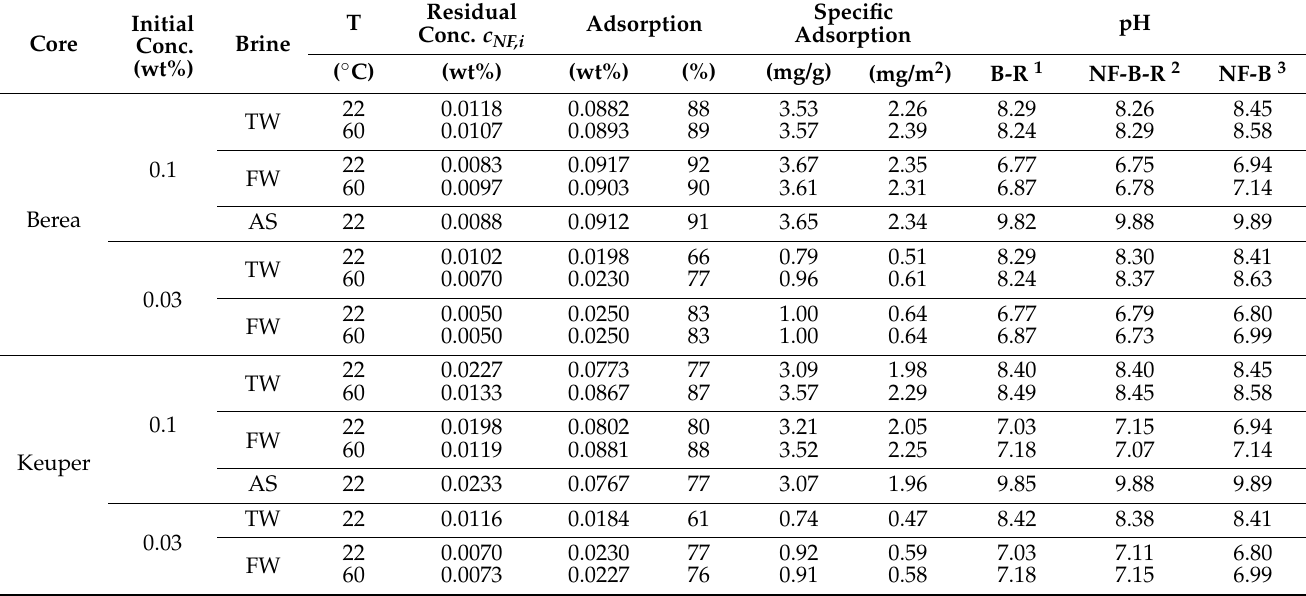
Table 5. Adsorption results and pH measurements for NF A in Berea and Keuper. Absorbance measurements were performed in doublets with an average standard deviation of 1.8 × 10 − 3 for all fluids. pH standard deviation was defined as 2 × 10 − 2 for all fluids in average (FW: formation water, TW: test water, AS: alkali